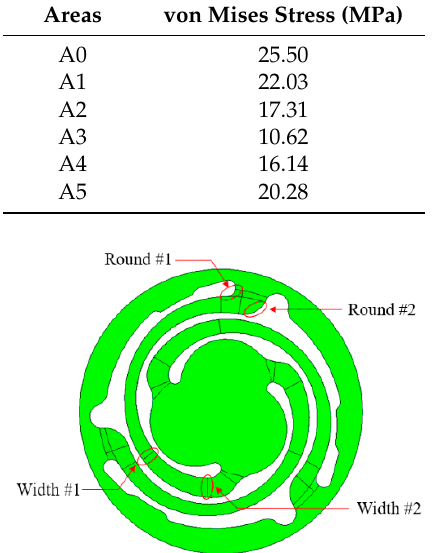
Figure 17. Four design parameters on prototype spring.